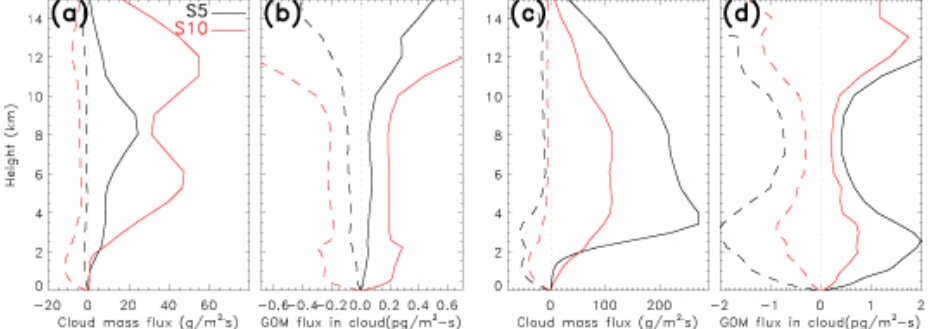
Fig. 10. Cloud mass flux and GOM flux in clouds for SHEAR categories 5ms − 1 (black) and 10ms − 1 (red). Panel (a) is average could mass flux and panel (b) is GOM mass flux in cloud for CAPE category c2500 and PW in p50. Panels (c) and (d) are the same as panels (a) and (b) , except for CAPE in c2500 and PW in p60. Solid lines show updrafts while downdrafts are shown with dashed lines.